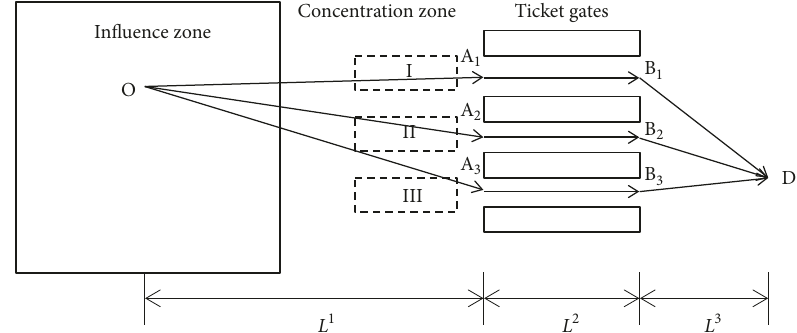
Figure 5: Illustration of local route algorithm.